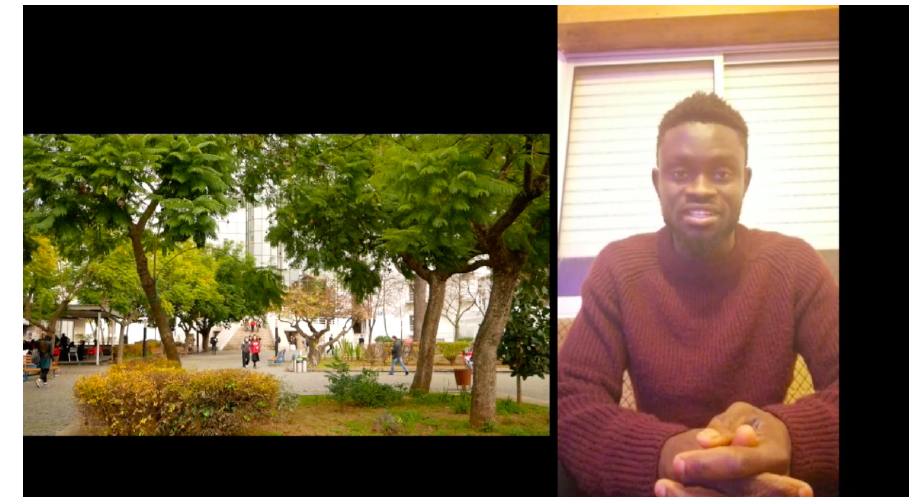
Figure 3. Film still from “From Here and There.” Source: Miranda